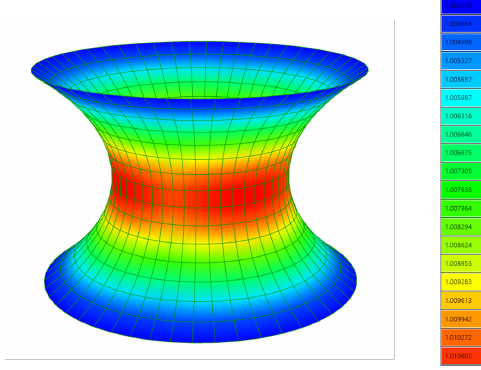
Figure 22: Last viable shape before solution diverges.